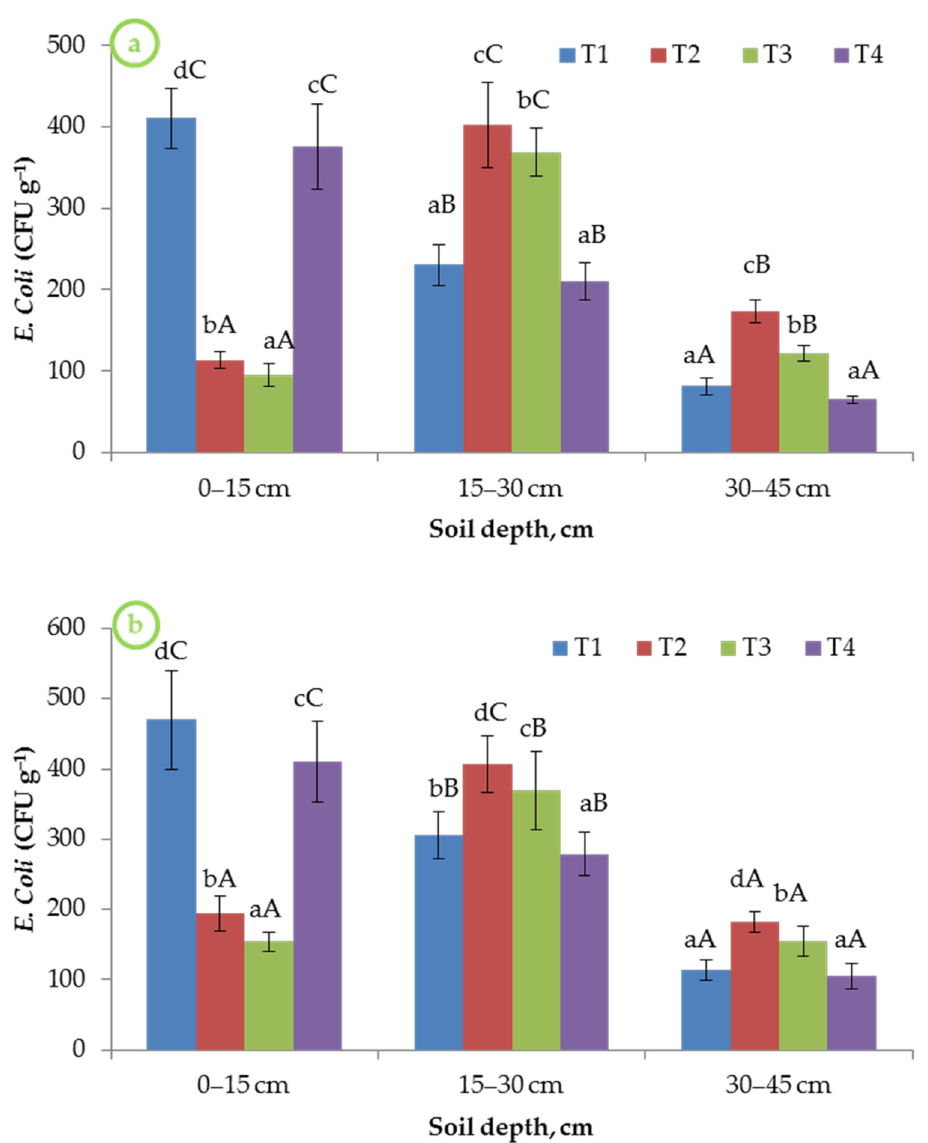
Figure 8. Presence of E. coli in soil under di ff erent treatments. ( a ) and ( b ) show depth-wise variations of E. coli in cauliflower and bitter gourd harvested soil, respectively. Vertical bars for each column represent standard deviations ( n = 3) of the means. Means of di ff erent treatments followed by di ff erent lowercase letters (a–d) are significantly di ff erent ( p < 0.05) at the same depth, whereas di ff erent uppercase letters (A–C) denote significant di ff erences ( p < 0.05) among the depths .